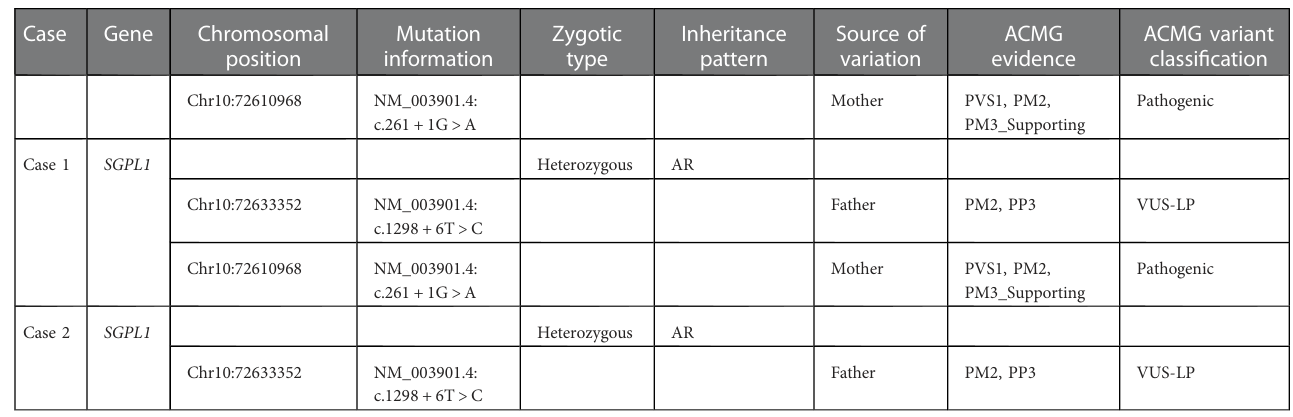
TABLE 1 Whole exome sequencing results of case 1 and case